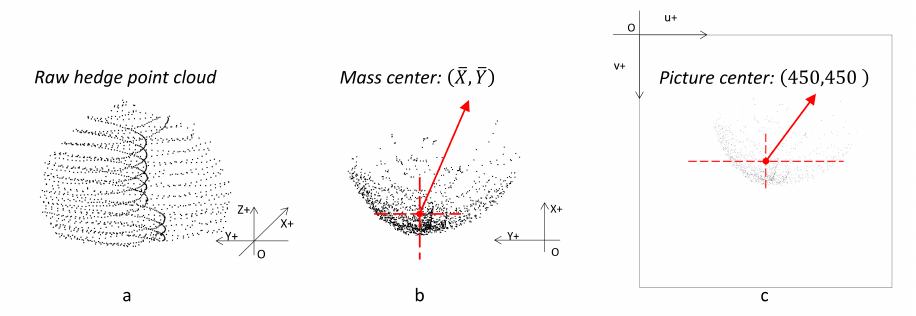
Figure 3. The transformation from spatial point cloud to planar image. To clearly show the position relationship between ( b ) and ( c ), we swapped the pixel values of 0 and 255 in ( c